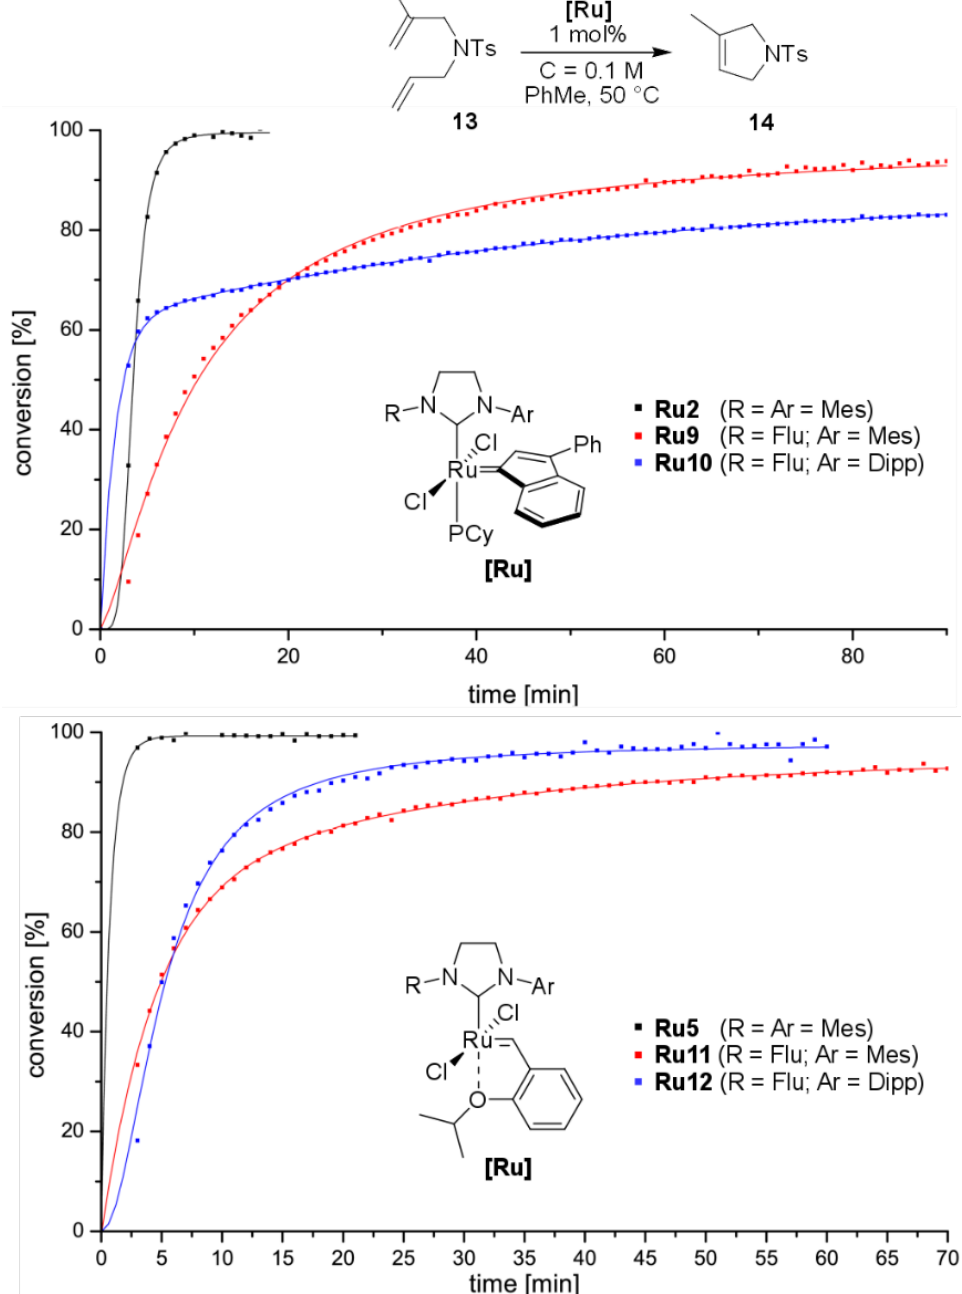
Figure 6. Time-conversion curves for RCM of 13 . Flu = fluoren-9-yl. Lines are as a visual aid only. With the basic profiling of new uNHC complexes completed, we examined them in a more diverse set of RCM reactions (Table 2). We attempted these tests not because we believed the fluorenyl uNHC catalysts will find applications in natural products synthesis or in medicinal chemistry—the fields of applications where catalysts bearing symmetrical NHC are traditionally much more suitable [50,51]—but to be consistent with our previous studies using similar sets of more advanced substrates [26,48,52]. ◦ All reactions were performed in 0.1 M solution in toluene at 60 C in the presence of 1000 ppm (0.1 mol